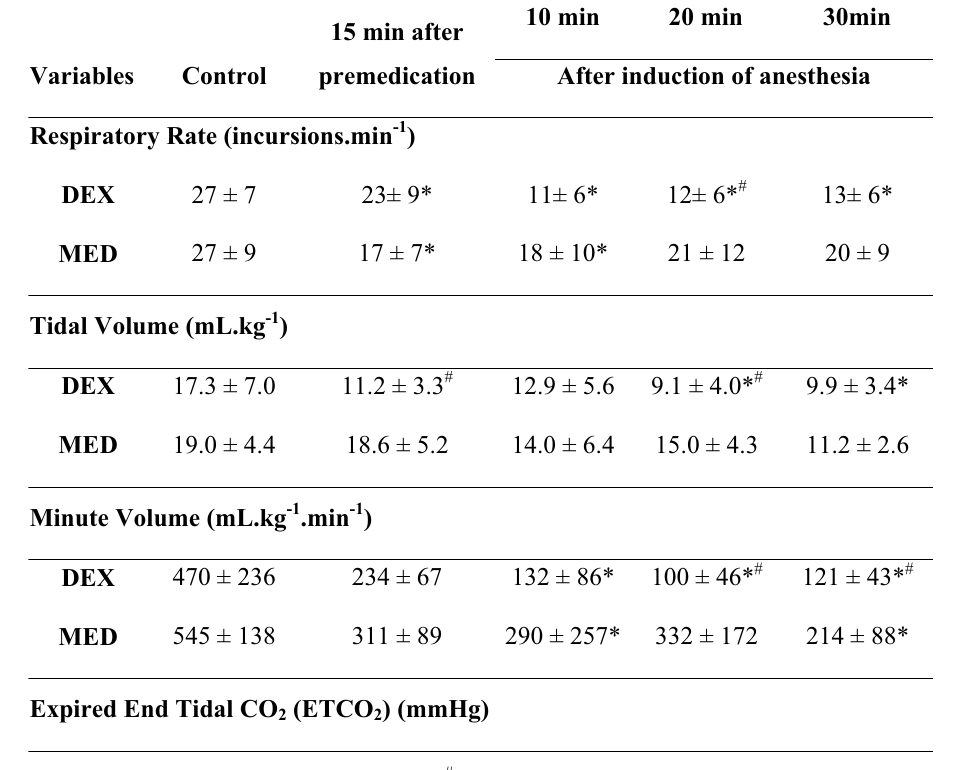
TABLE 1 – Hemodynamic parameters of dexmedetomidine group (DEX) and medetomidine group (MED) at the observation times